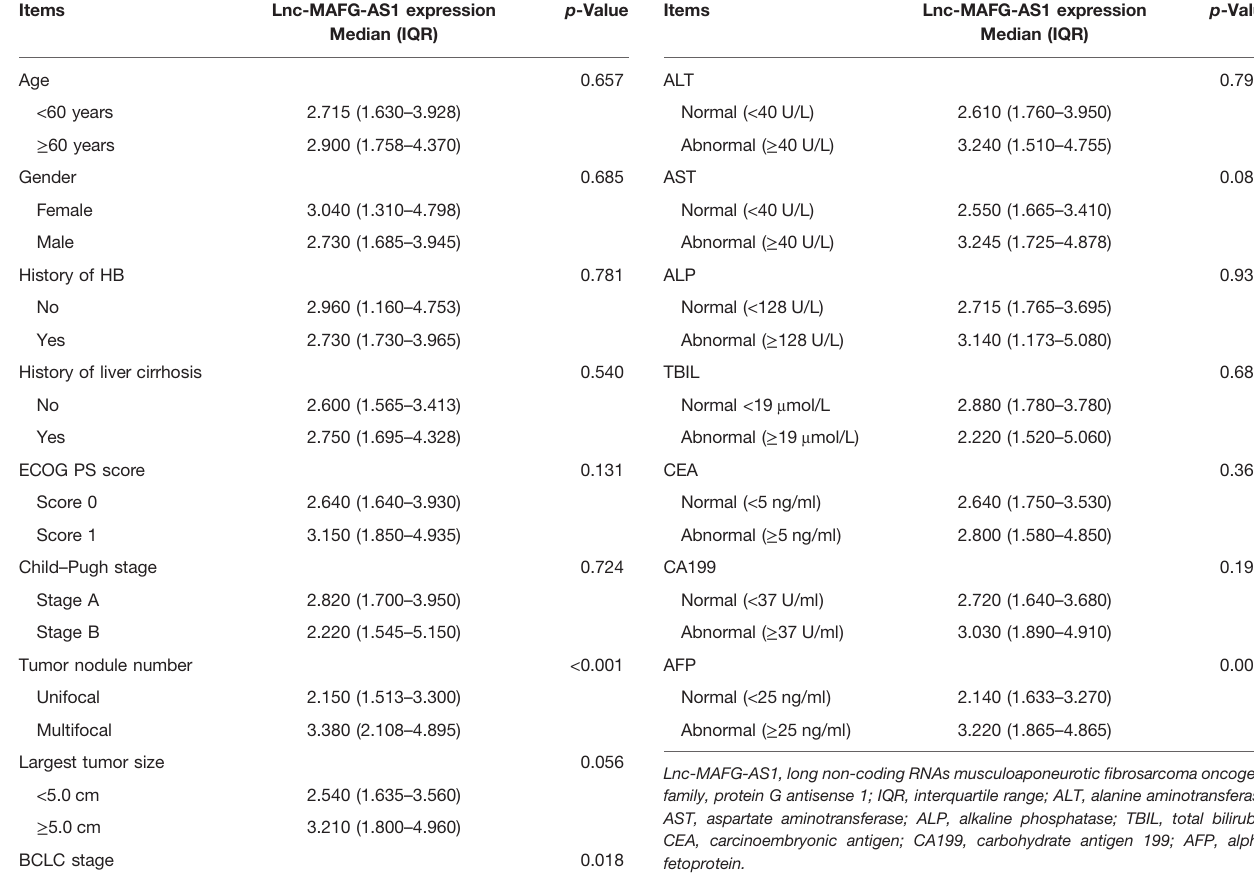
TABLE 3 | Correlation of lnc-MAFG-AS1 expression with liver function indexes and tumor markers.